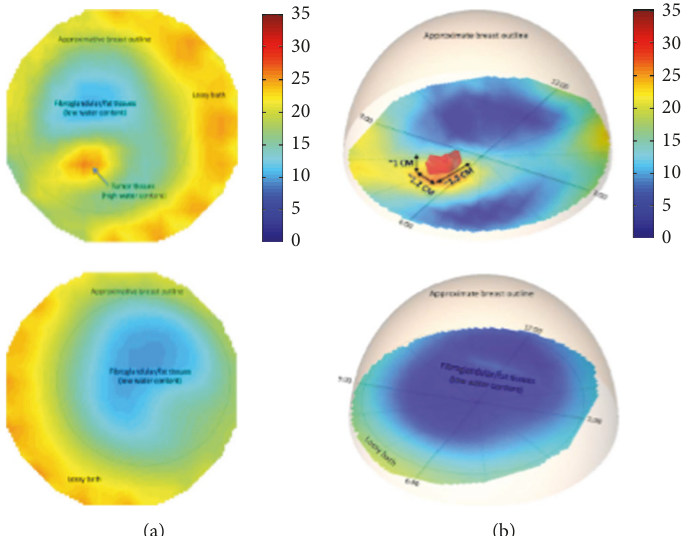
Figure 11: Microwave tomographic permittivity images at 1300 MHz from Dartmouth College; upper: right breast; lower: left breast. (a) 2D images and (b) 3D images [20]. Image copyright IEEE, used with